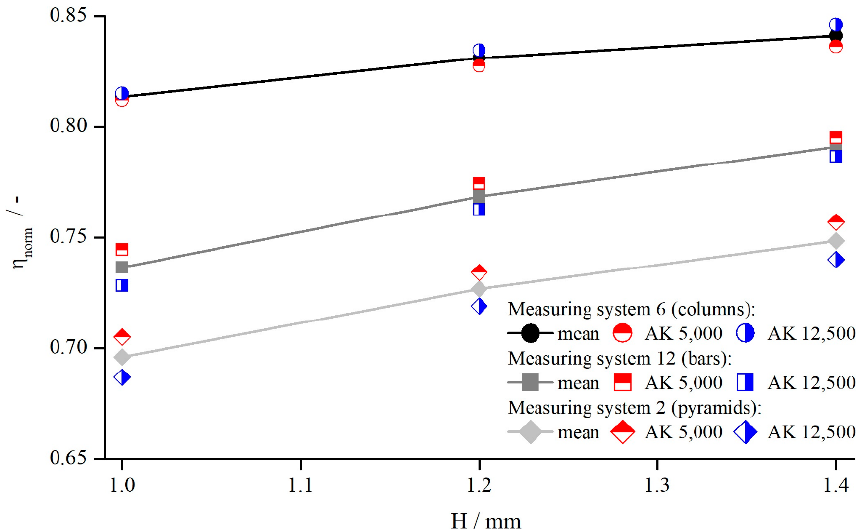
. γ . γ in the velocity profile a and true shear rate